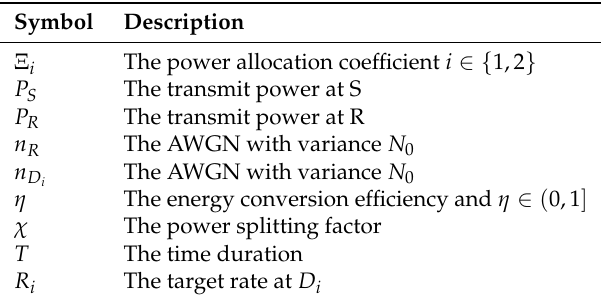
Figure 1. Illustration of energy harvesting HSTRN using NOMA. Table 1. Key parameters of the system